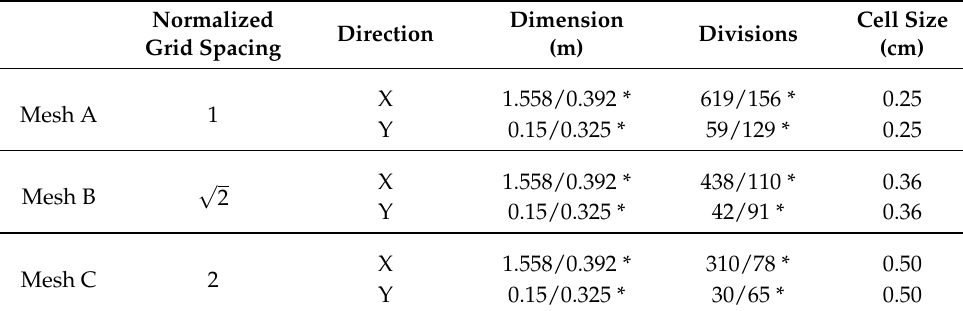
Figure 2. Mean y+ values for Mesh A, B, and C. Table 2. Characteristics of Mesh A, B, and